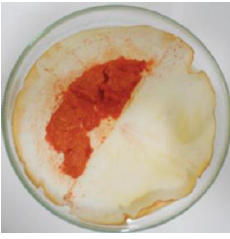
Figure 2. The compound synthesized after recrystallization using the microwave method. Red crystals (Figure 2) have 190ᵒC, with sharp melting points. Thin-layer chromatography (TLC) results showed the compound had one spot when eluted with three different mobile phases (Figure 3). The purity test with silica stationary phase TLC of Silica GF 254 showed one yellow spot at different mobile phases. The compound is confirmed to be pure by melting point and TLC